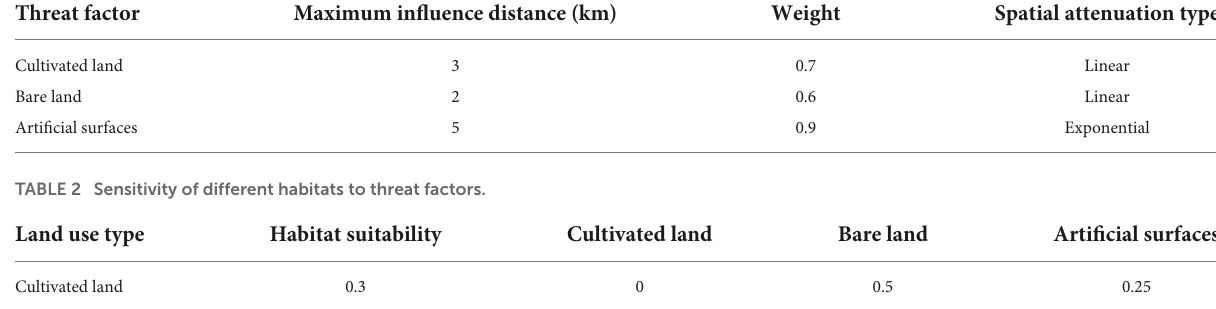
TABLE 1 Influence range and weight of threat factors.